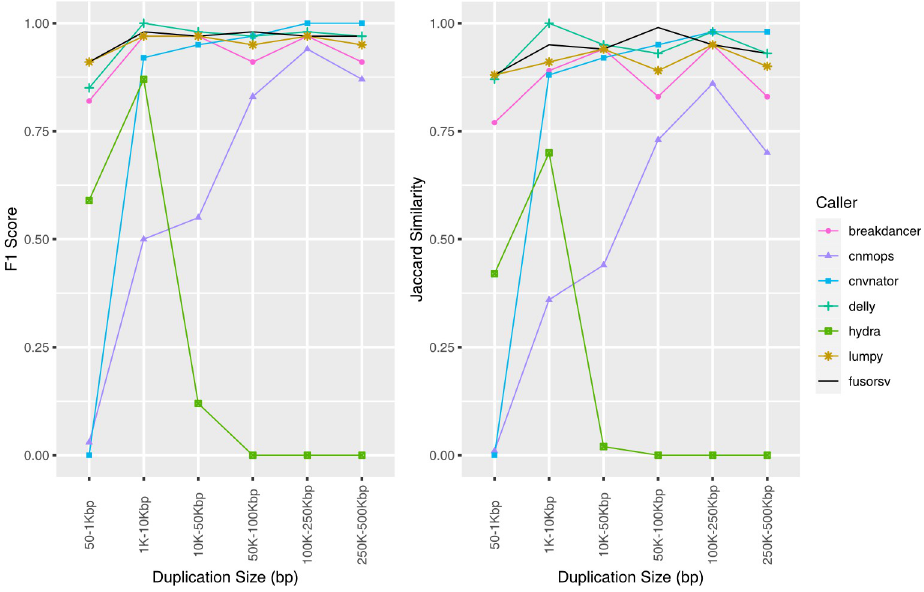
Fig 2. Accuracy of predicted duplications from simulated short-read data. Results shown for 60X